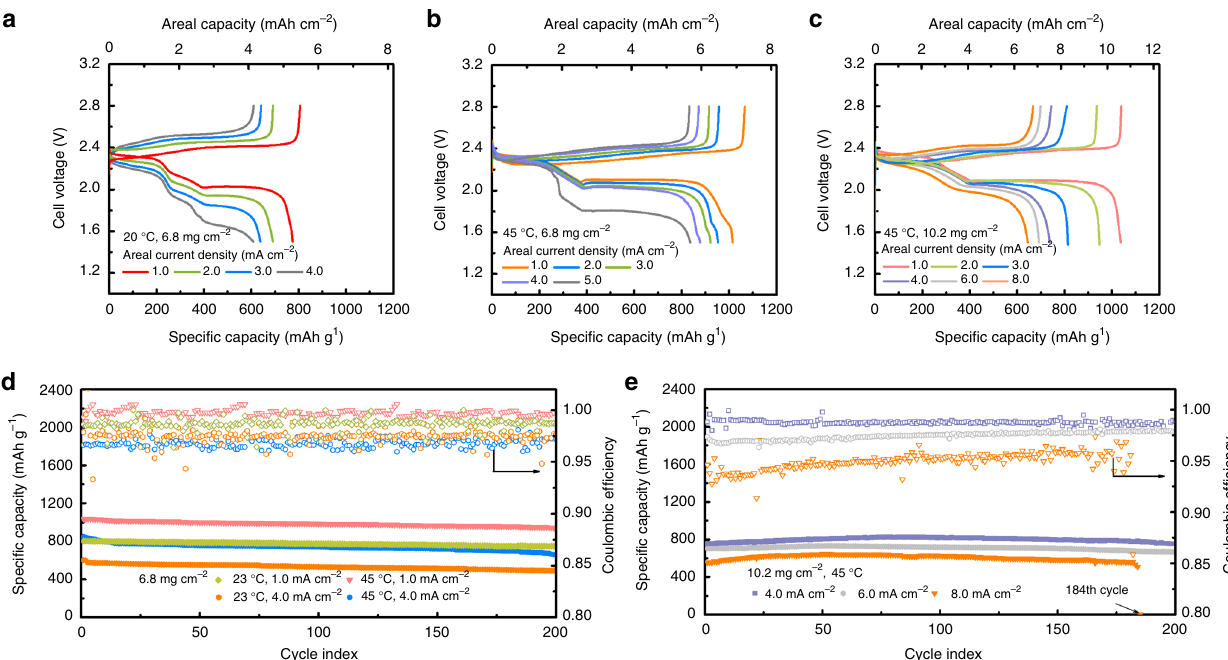
Fig. 6 Performance of a Li – S battery employing the MFC-Li/CNF electrode. a , b Voltage pro fi les of Li – S batteries with a sulfur loading of 6.8 mg cm − 2 at 23 °C ( a ); and at 45 °C ( b ). c Voltage pro fi les of Li – S batteries with a sulfur loading of 10.2 mg cm − 2 at 45 °C. d Cycling performance with a sulfur loading of 6.8 mg cm − 2 at 1.0 or 4.0 mA cm − 2 , at 23 °C or 45 °C. e Cycling performance with a sulfur loading of 10.2 mg cm − 2 at 4.0, 6.0 or 8.0 mA cm − 2 at 45